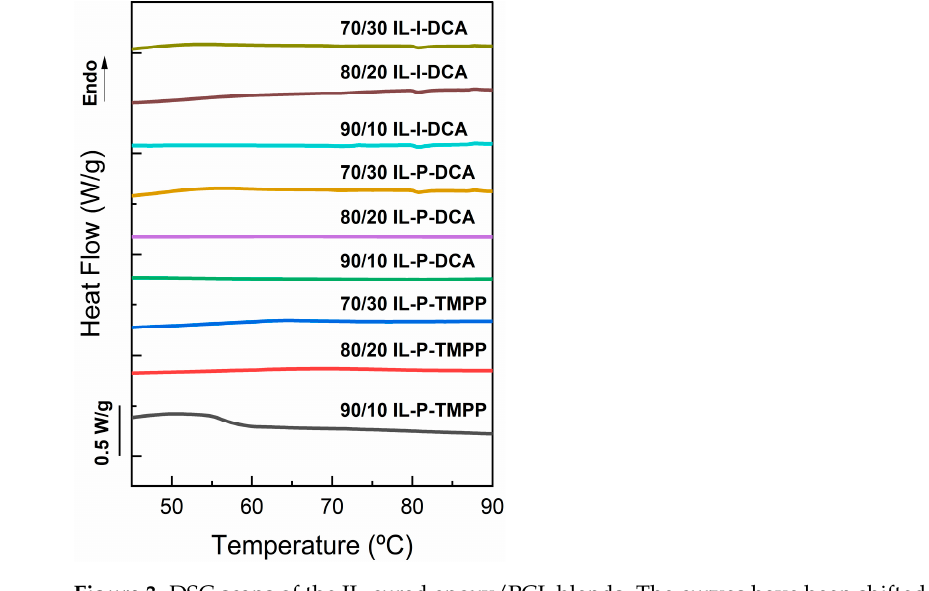
Figure 3. DSC scans of the IL-cured epoxy/PCL blends. The curves have been shifted in the Y -axis for